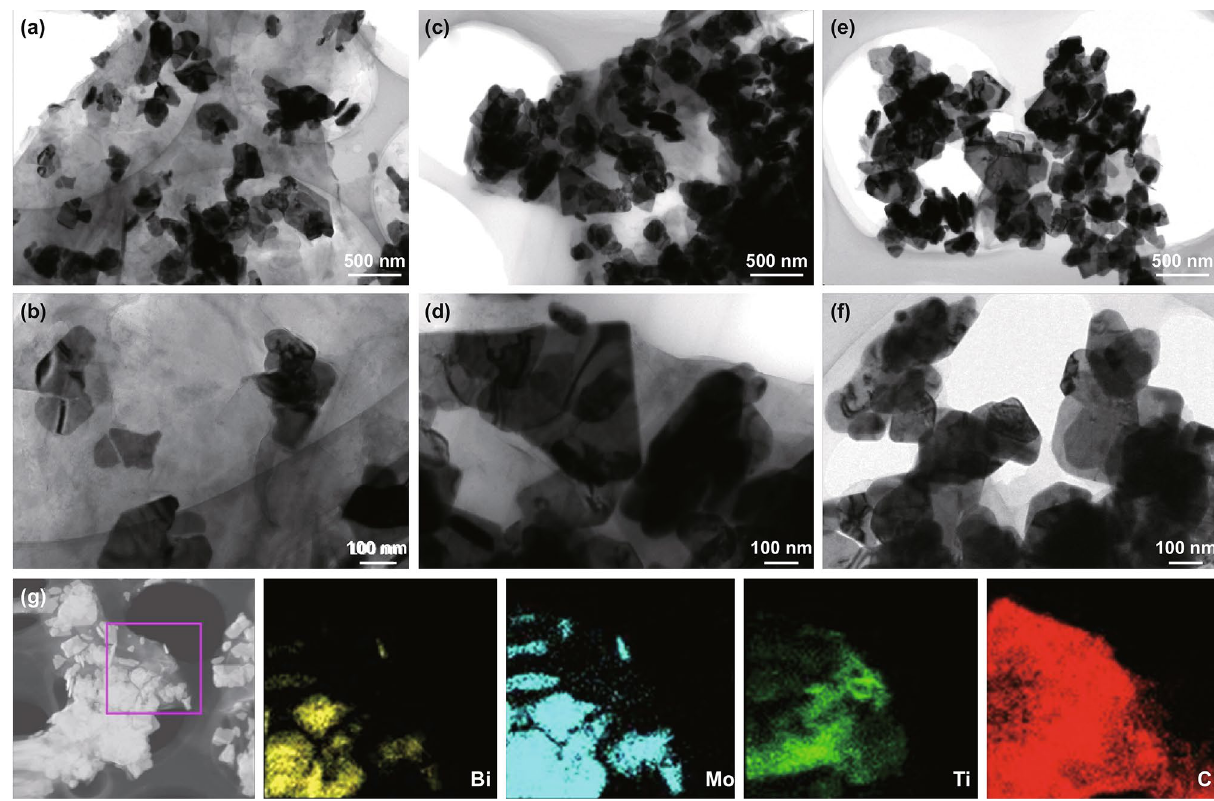
Fig. 3 TEM images of a , b Bi 2 MoO 6 /MXene‑50%, c , d Bi 2 MoO 6 /MXene‑30%, and e , f Bi 2 MoO 6 /MXene‑10%. g STEM and corresponding ele‑ ment (Bi, Mo, Ti, and C) mapping images of the Bi 2 MoO 6